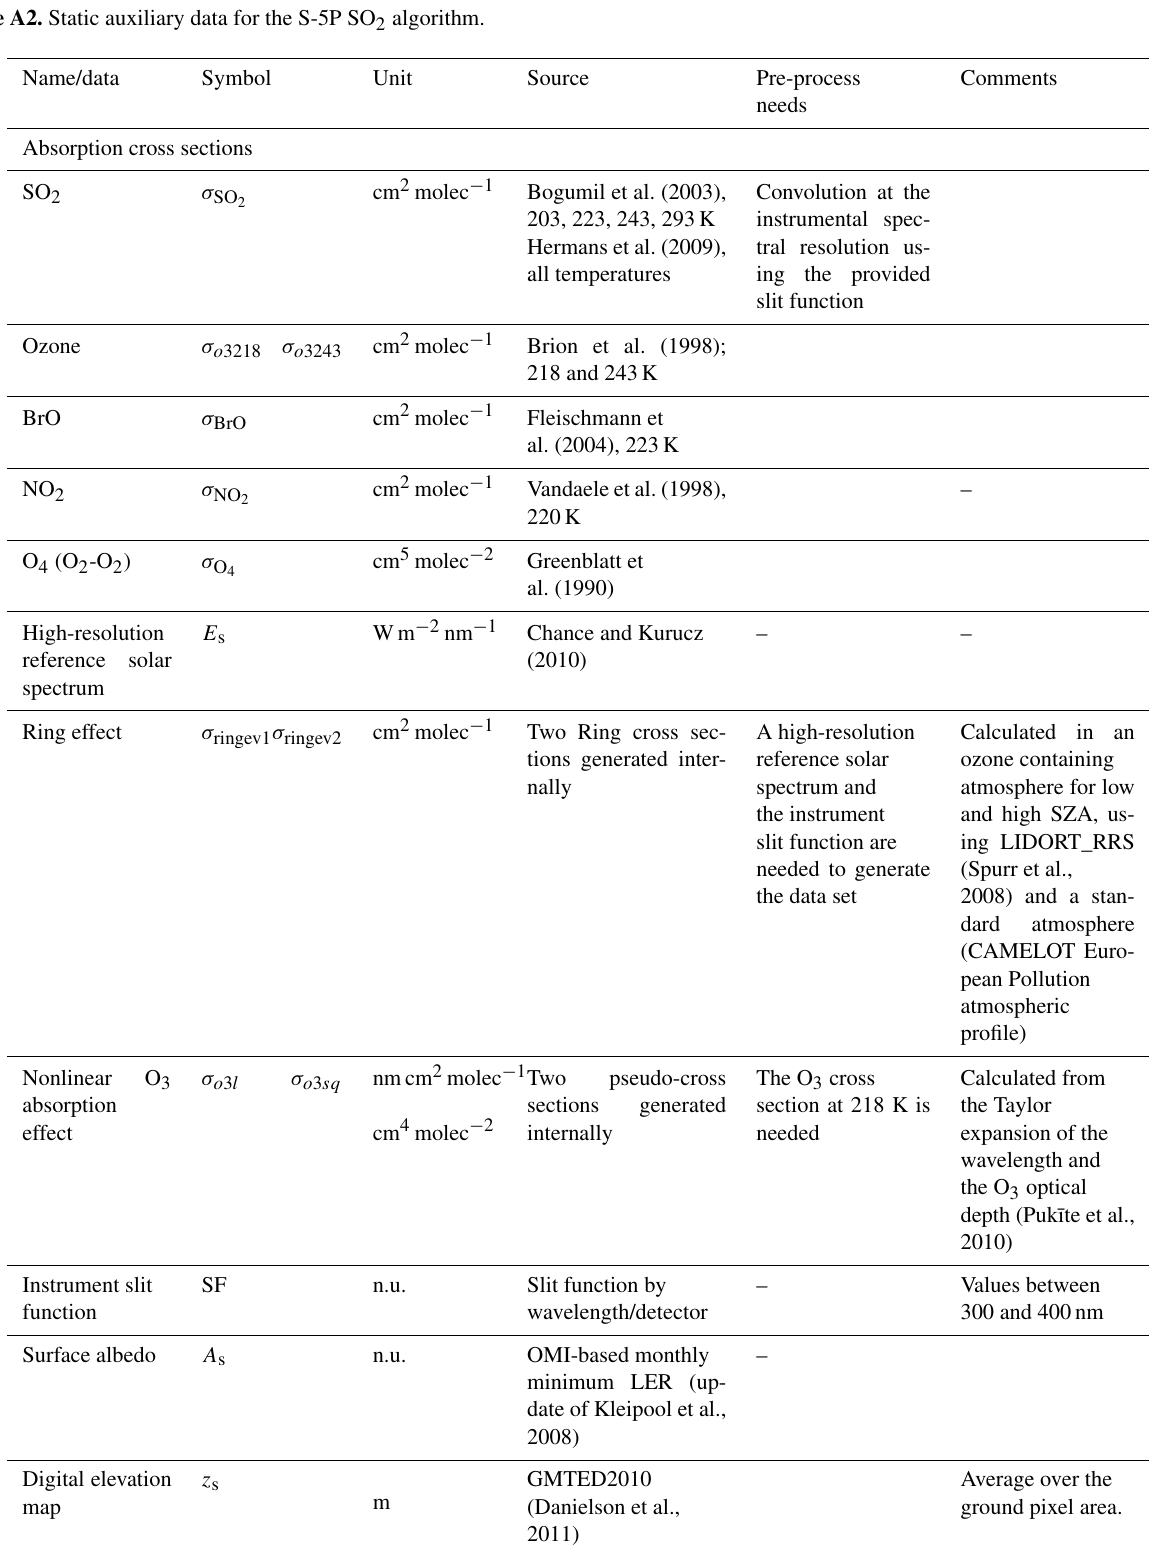
Table A2. Static auxiliary data for the S-5P SO 2